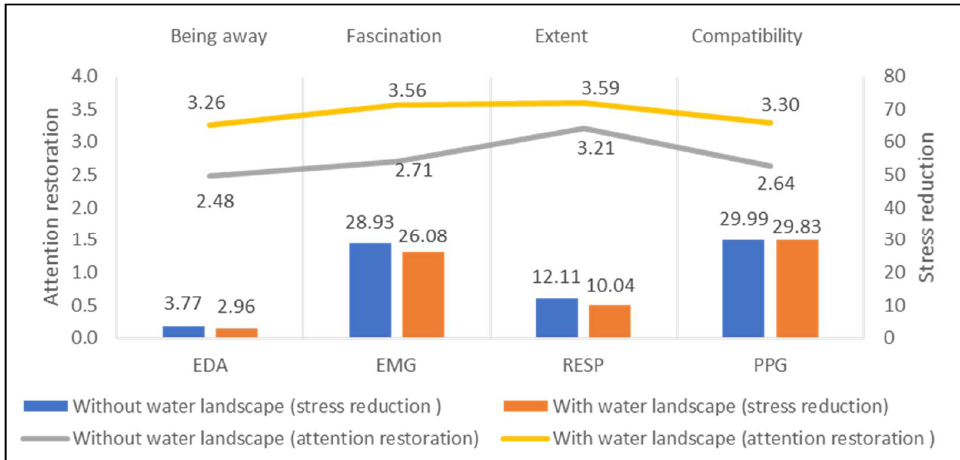
Figure 5. Impacts of water landscape on stress recovery and attention restoration.